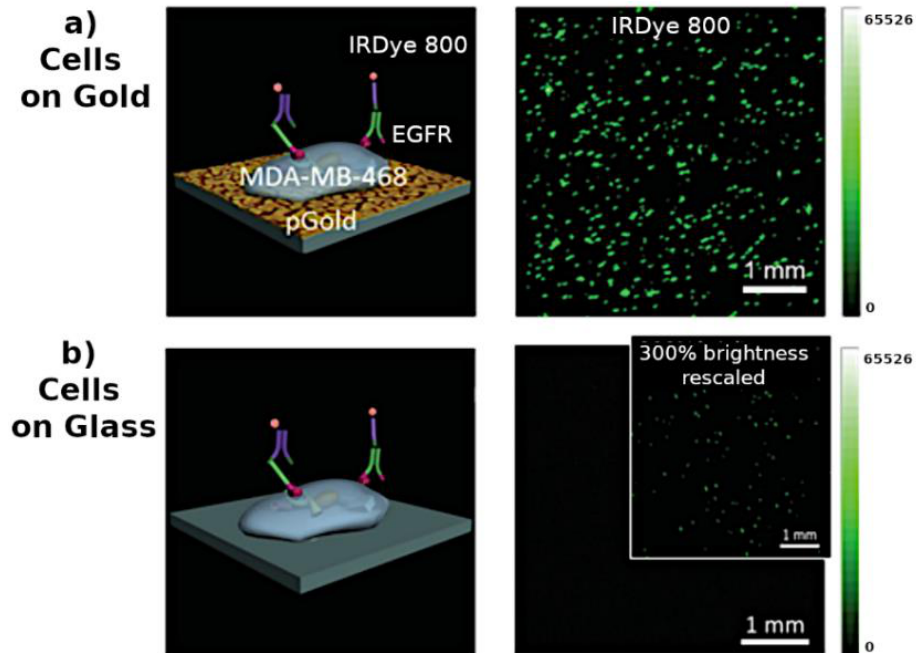
Figure 10. Nanoplasmonic gold platform that shows the enhanced fluorescence due to the plasmon effect in comparison to a glass surface for the detection of cellular components. Adapted with permission from [297] Copyright 2015 John Wiley and